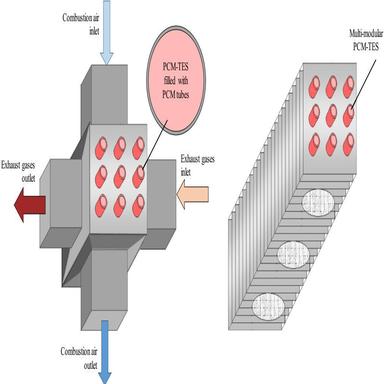
Diagram of a crossflow PCM-TES with simultaneous flows and filled PCM tubes.